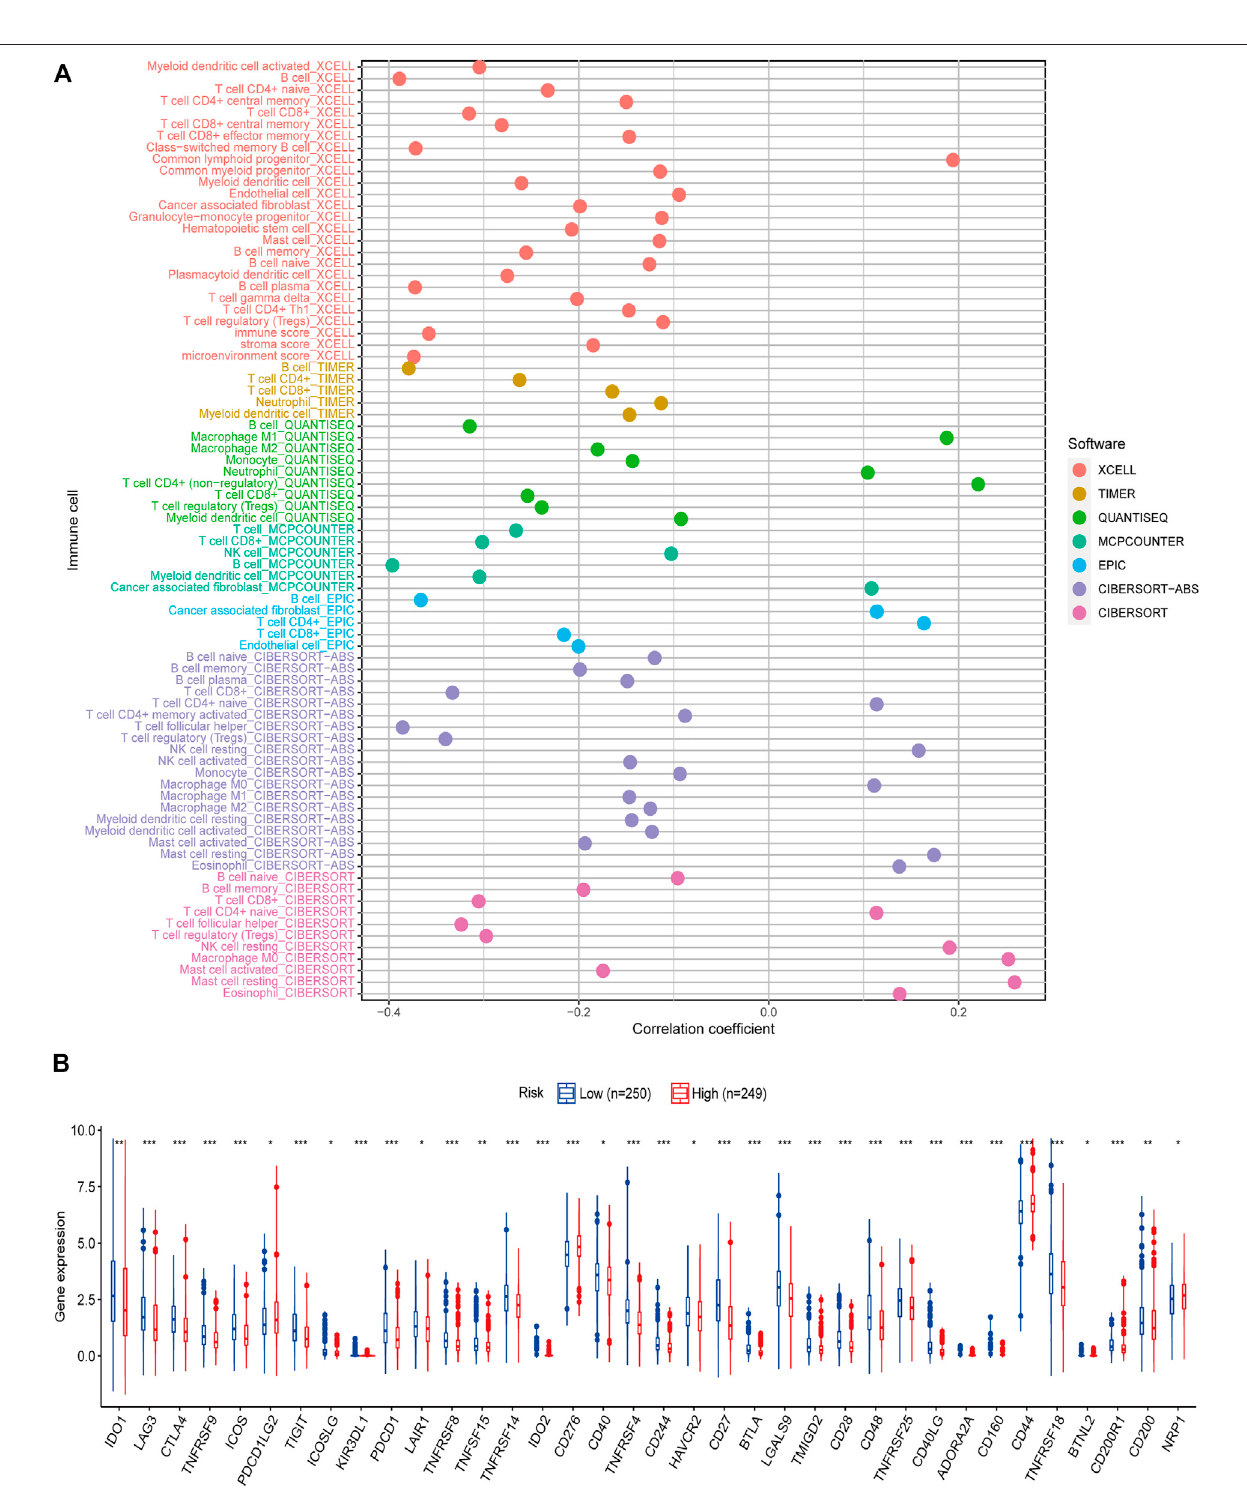
FIGURE 7 | Correlation of tumor-in fi ltrating cells and immune checkpoints with risk scores. (A) A lollipop diagram shows that high-risk score was positively related to M0, M1 macrophages, and resting NK cells in fi ltrating, whereas it was negatively associated with B cells, CD8 T cells, M2 macrophages, myeloid dendritic cells, and monocytes in fi ltratingin head and neck squamous cell carcinoma patients. (B) Expression ofimmune checkpoints among high- ( n = 249) and low-risk groups ( n =250). * p < 0.05, ** p < 0.01, *** p < 0.001.